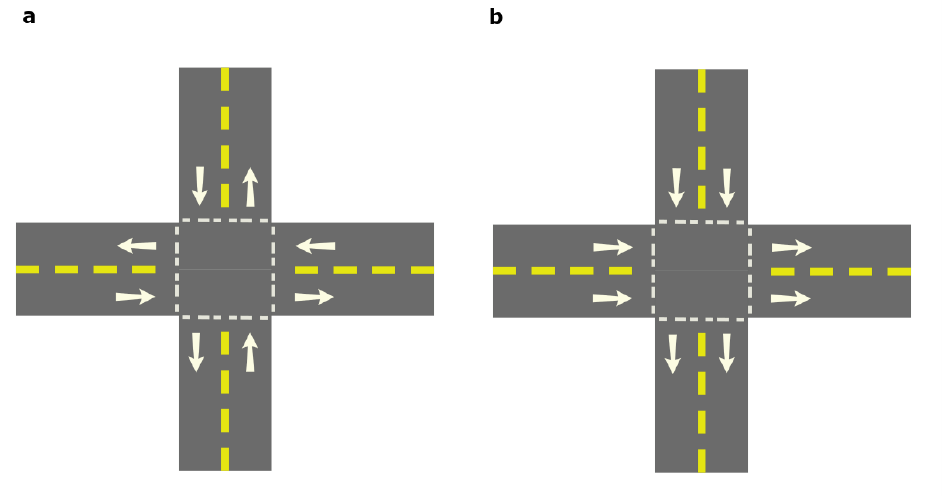
Figure 1. Typical intersection configuration for road-based traffic. ( a ) Two-way network. ( b ) One-way network. Note that the arrows depict the direction of traffic